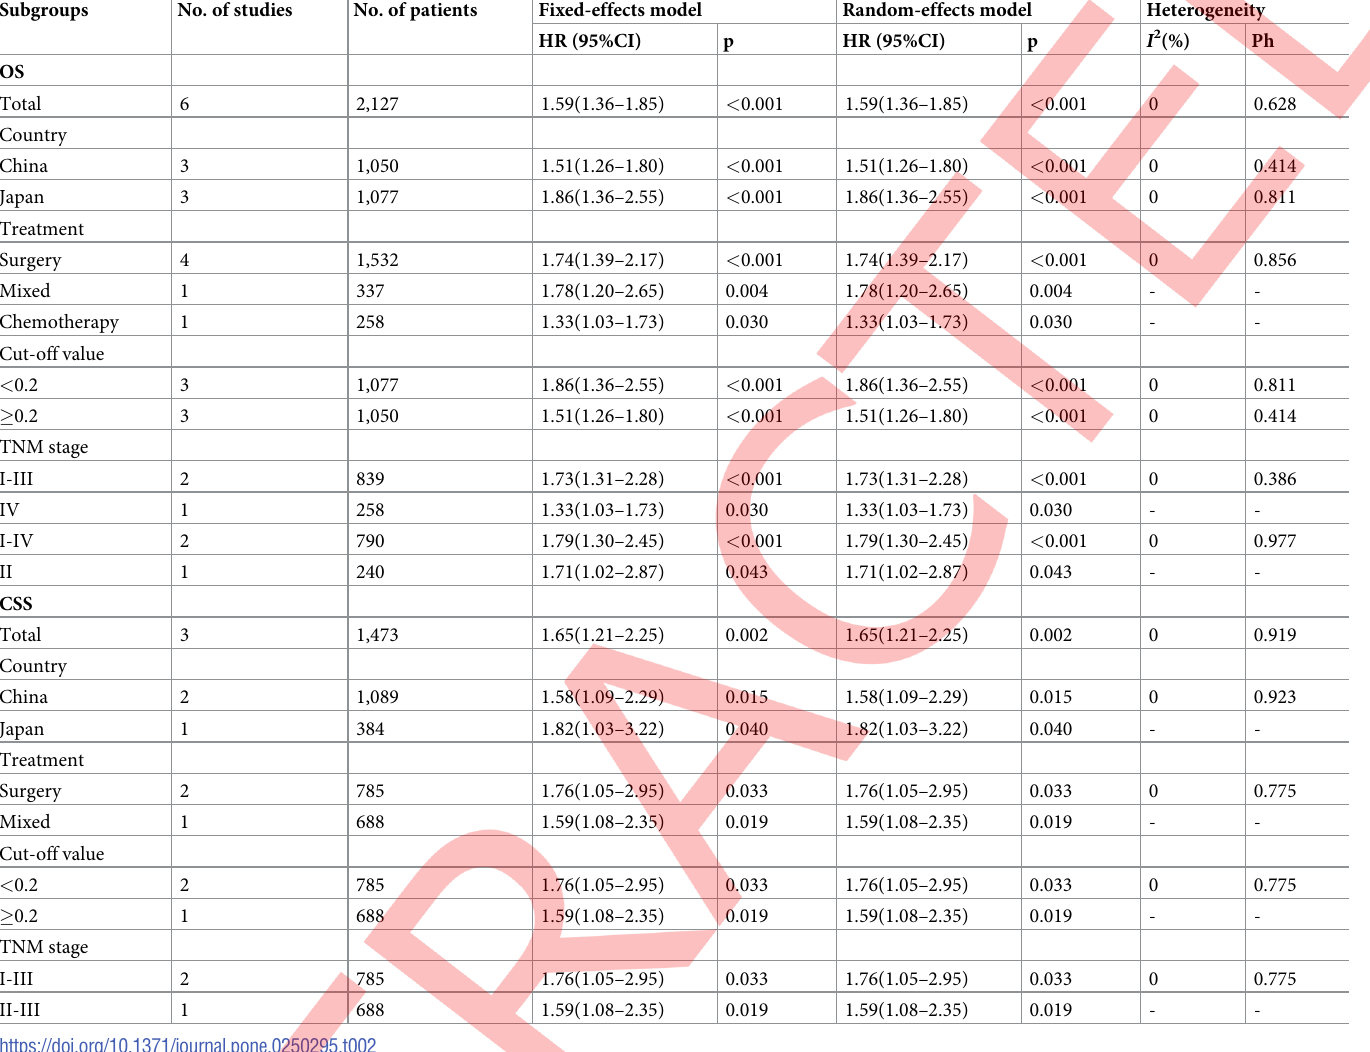
Table 2. The subgroup analyses for the association between CAR and OS and CSS in gastric